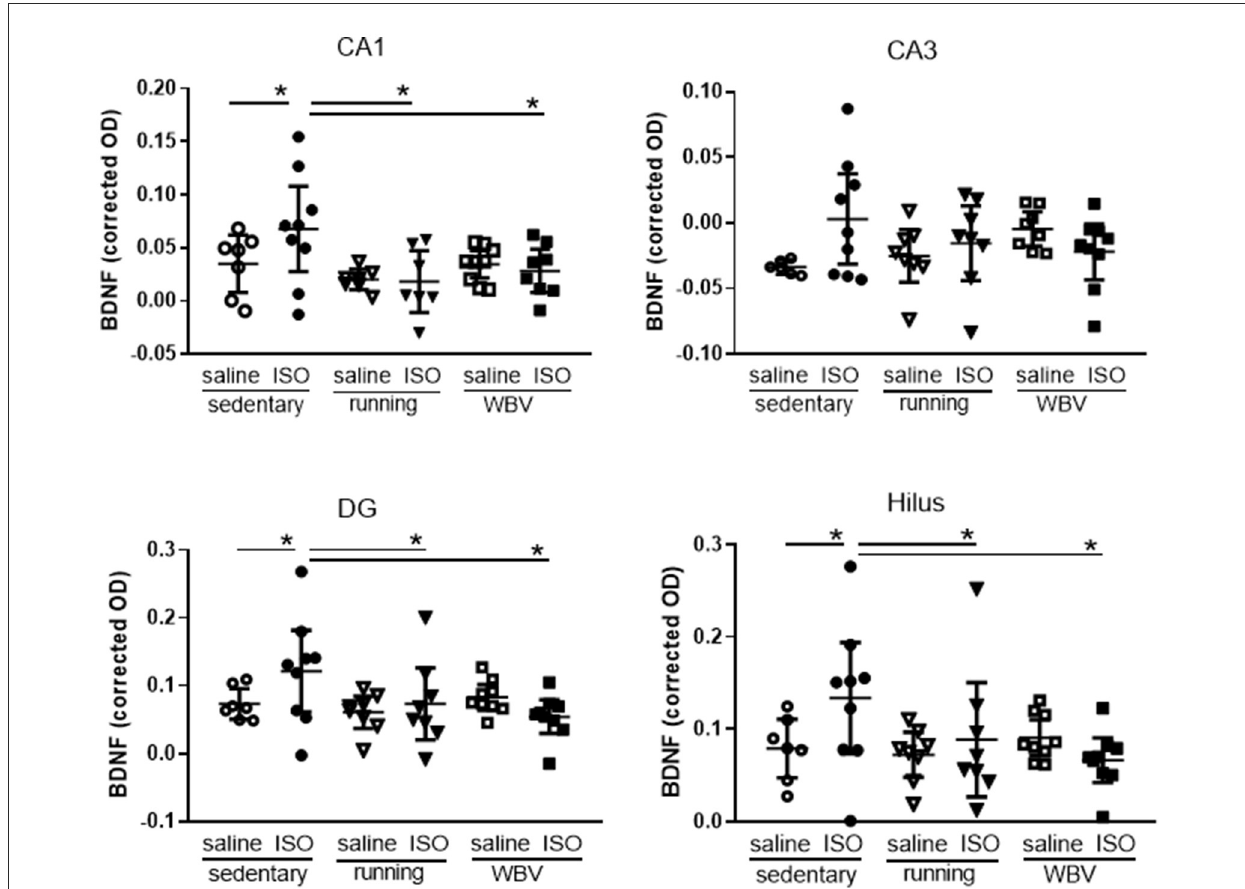
FIGURE7 Expression of brain-derived neurotrophic factor (BDNF) in the different areas of the hippocampus in saline- or isoproterenol (ISO)-treated rats, under sedentary conditions ( n = 7 and n = 9, respectively), or after 5 weeks of exercise training (running; n = 8 each) or whole-body vibration (vibration; n = 9 each). *Significant difference between indicated groups in post-hoc analyses ( p <